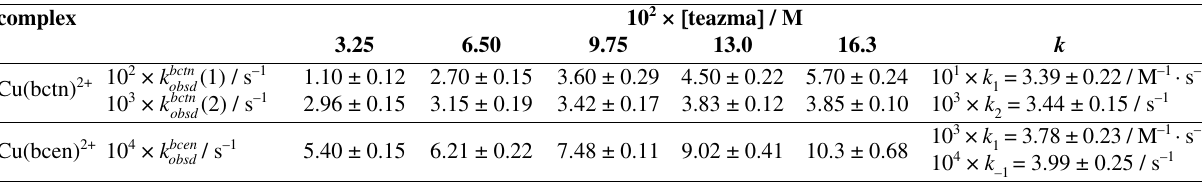
Table 1. Rate constants data for the reaction of Cu complexes, 6.5 × 10 –3 M, with teazma ligand in DMF